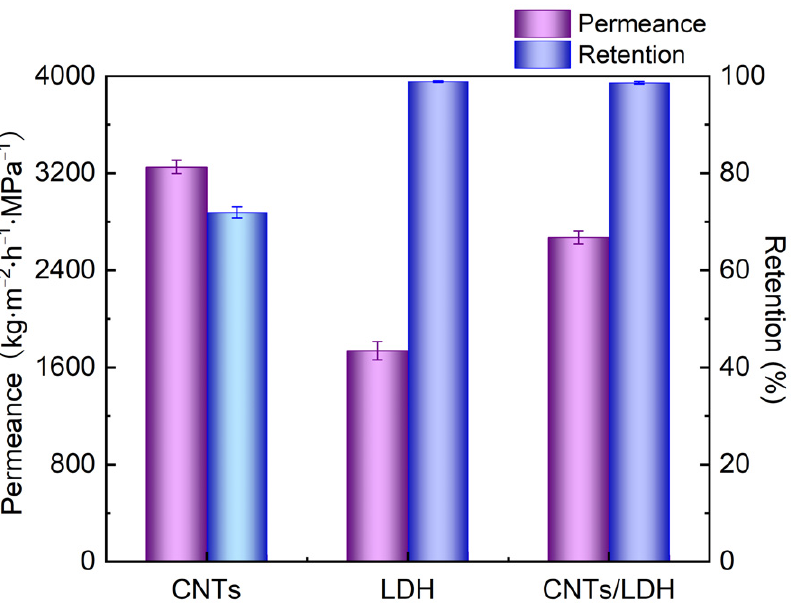
Figure 5. Dye removal performance of CNT, LDH, and CNTs/LDH membranes (operation condition: 0.1 g/L Evans blue aqueous solution; operating pressure: 0.1 MPa).